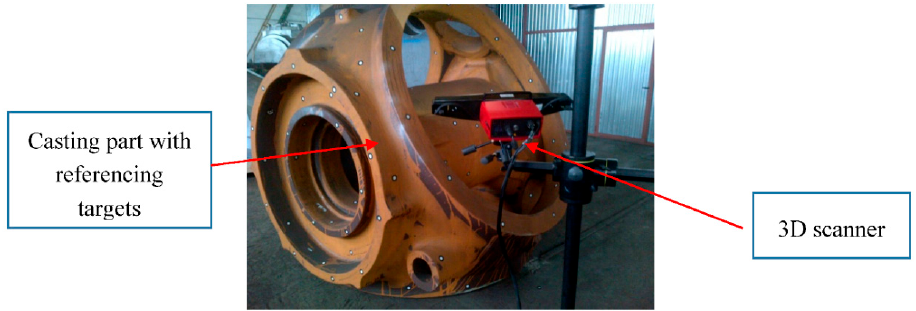
Figure 3. Scanning of casting part by means of structure light scanner and reference targets.